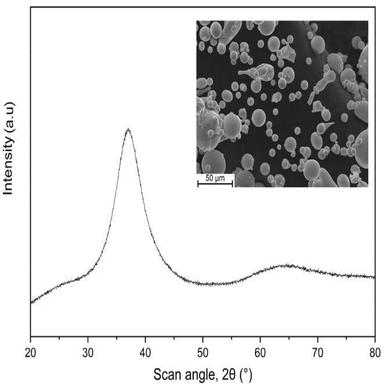
Laboratory XRD pattern (CuΚα radiation) of the gas-atomized powder. The inset shows an SEM image of the powder particles, which mostly have a spherical shape.